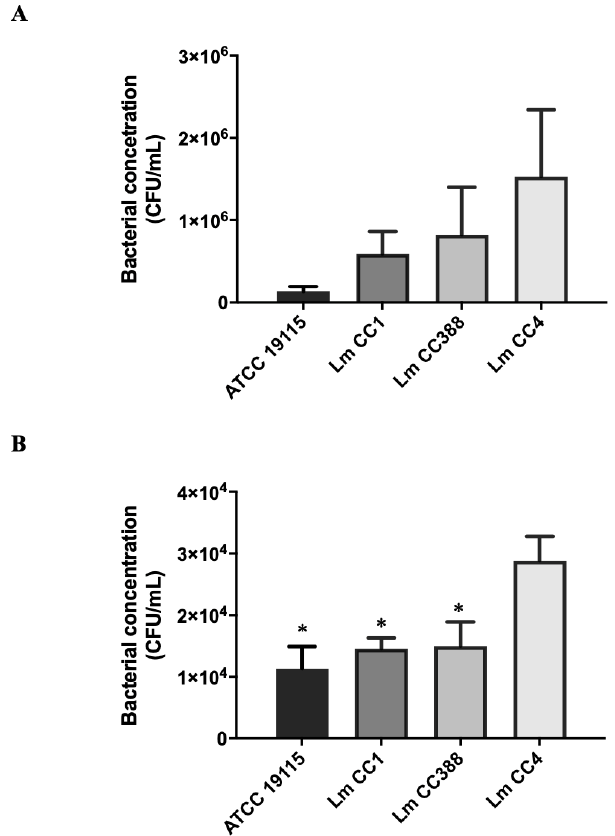
Figure 1. L. monocytogenes adherence and invasion in host cells. ( A ) Analysis of bacterial adherence in A549 cells incubated with L. monocytogenes Lm CC88, Lm CC1, Lm CC4 and ATCC 19115 strains. ( B ) Analysis of bacterial invasion in A549 cell incubated with L. monocytogenes Lm CC88, Lm CC1, Lm CC4 and ATCC 19115 strains. Data are the means of 3 repetitive assays. *: p < 0.05 versus Lm CC4 strain.